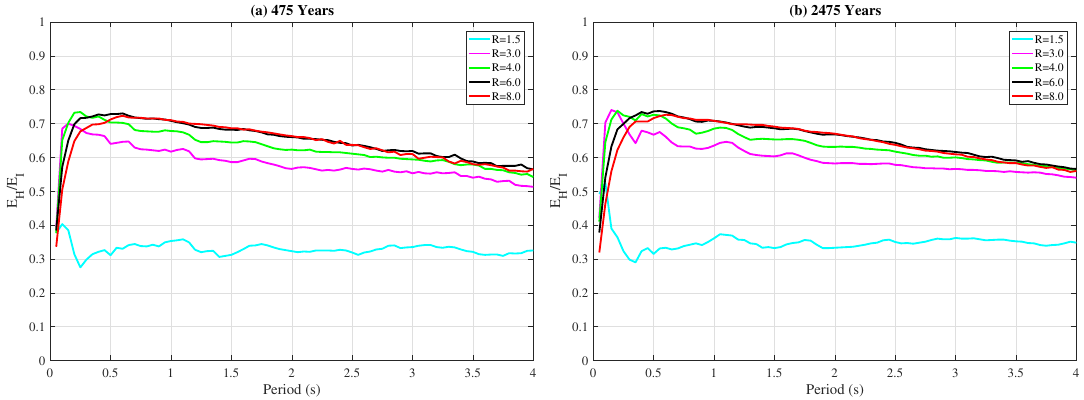
Figure 4. Ratio of hysteretic energy to total input energy for ( a ) 10/50 and ( b ) 2/50 sets.